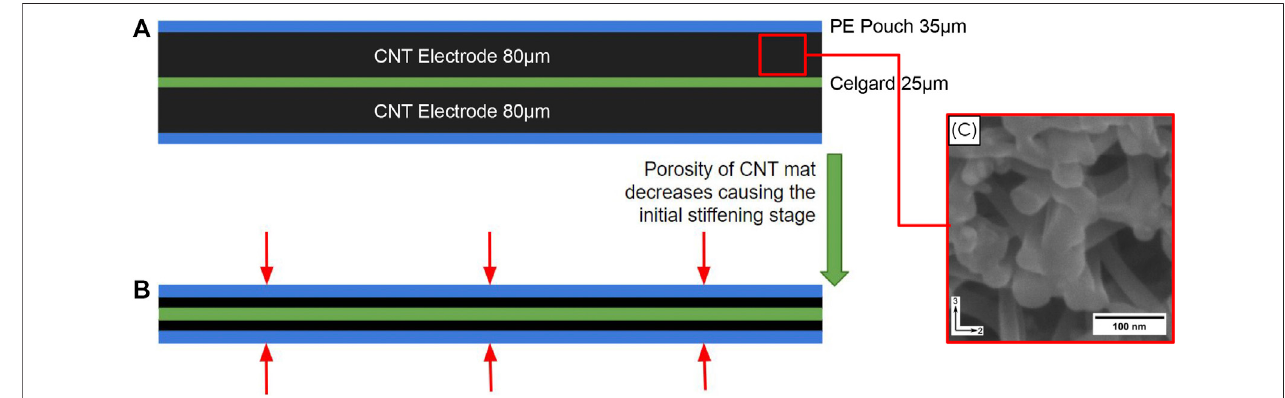
FIGURE 7 | Schematic showing (A) the layer thickness of a pure CNT EDLC cell used in nail penetration testing, (B) the compression and densi fi cation of the CNT matreducingtheporevolumefractionresultingintheinitialstiffeningstageoftheforce-displacementcurveand (C) anSEMimagetakensideontotheCNTmatshowing its porosity [Tan et al.